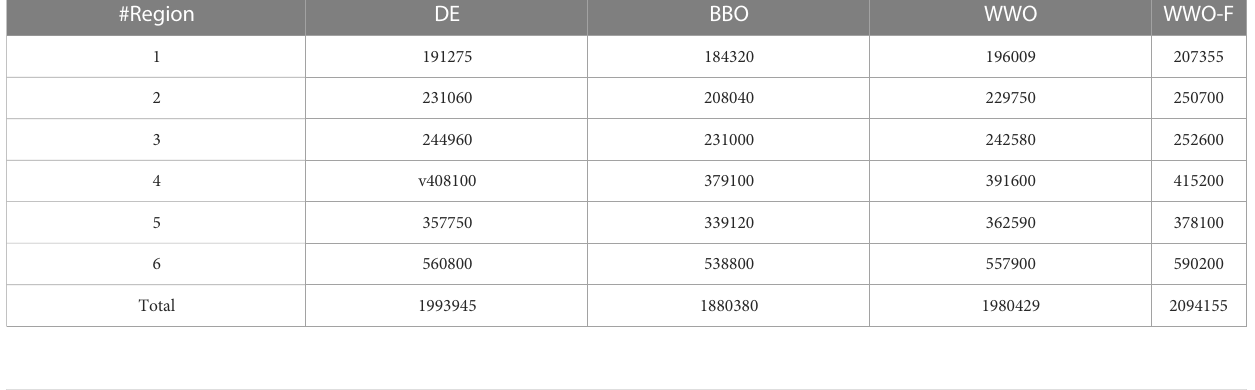
TABLE 2 Pro fi ts of the solutions obtained by the three non-fuzzy evolutionary algorithms and the proposed WWO with fuzzy optimization (WWO-F).